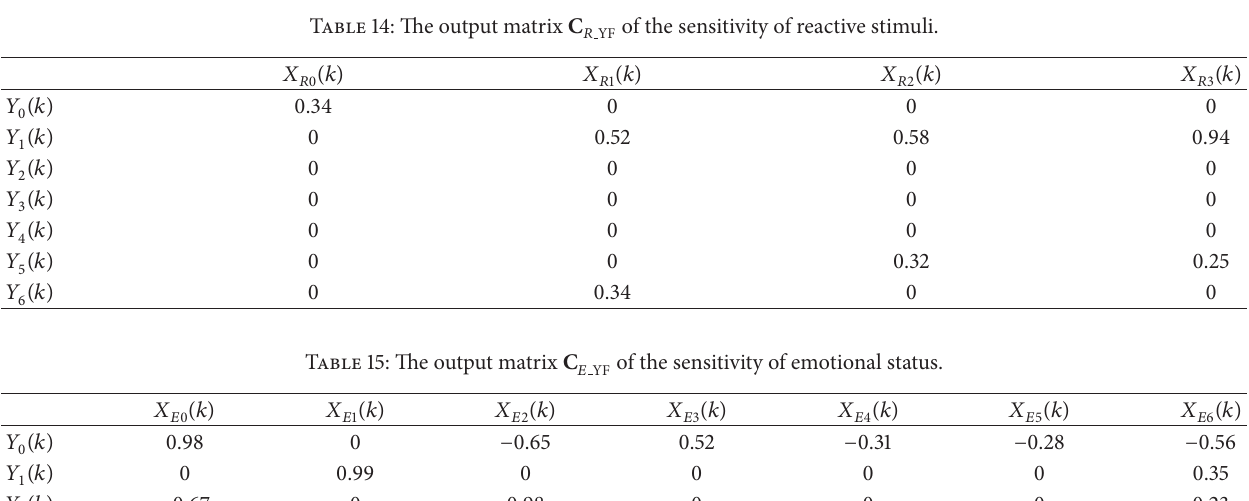
Table 14: The output matrix C 𝑅